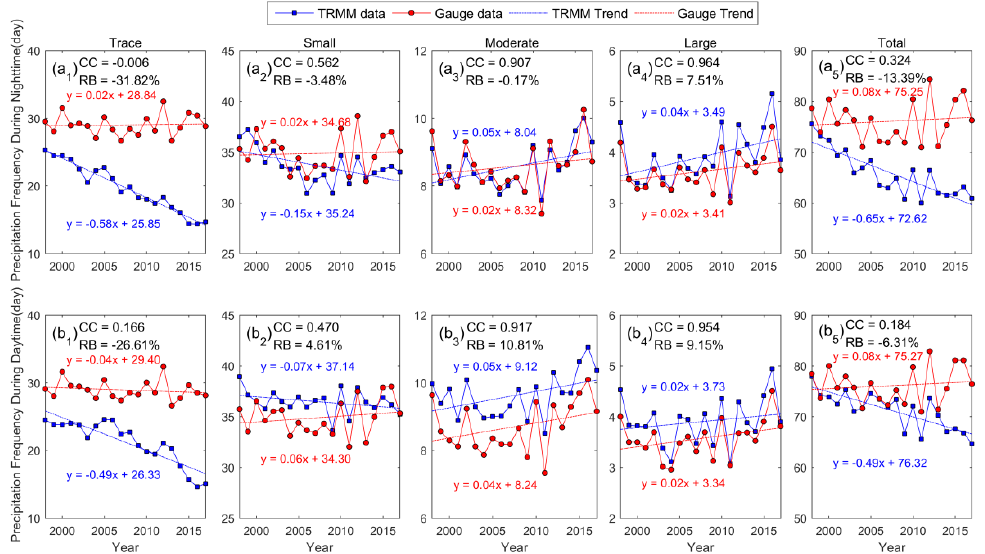
Figure 2. Interannual variations and linear trends of precipitation frequencies from TRMM 3B42 data and gauge data during the ( a ) nighttime and ( b ) daytime for di ff erent categories of intensity from 1998 to 2017 over mainland China. From left to right are days with a trace amount of rain ((0.1 ≤ P < 1 mm (12 h) − 1 )), a small amount of rain (1 ≤ P < 10 mm (12 h) − 1 ), a moderate amount of rain (10 ≤ P < 25 mm (12 h) − 1 ), a large amount of rain (P ≥ 25 mm (12 h) − 1 )), and the total precipitation (P ≥ 0.1 mm (12 h) − 1 ). The y -axis scales are di ff erent for di ff erent precipitation categories.